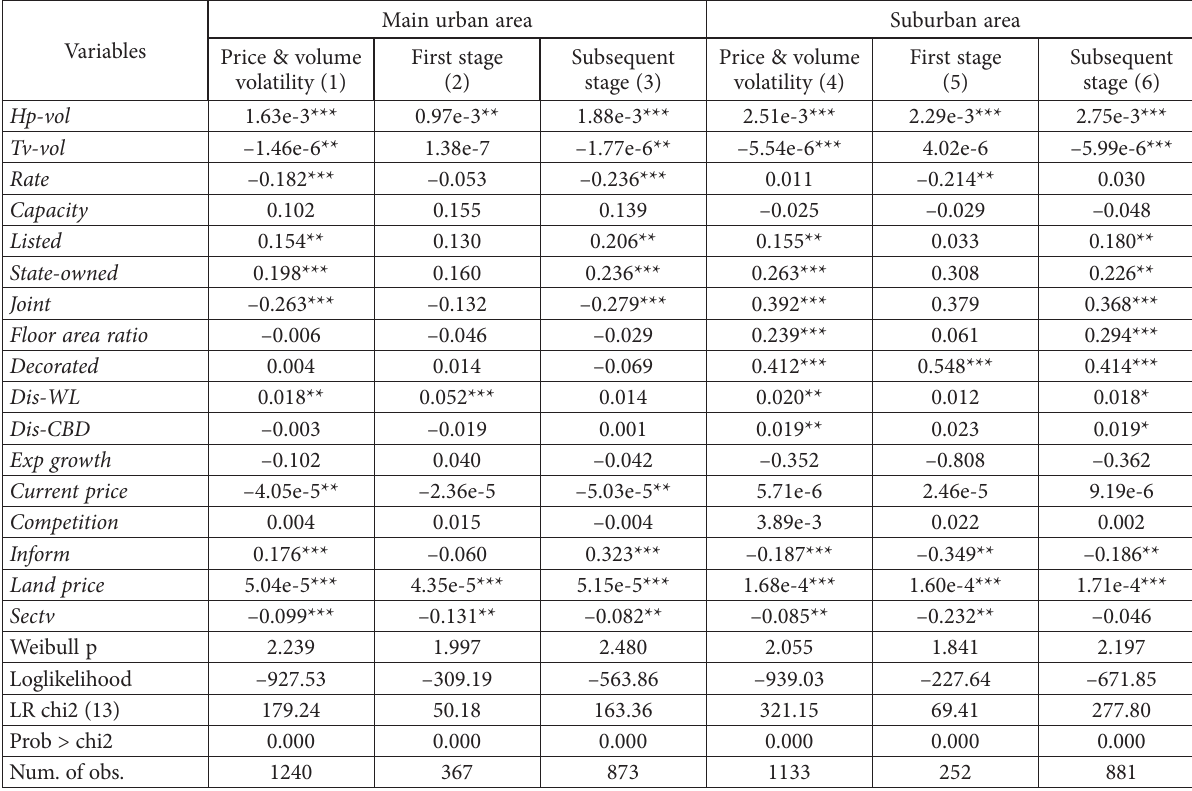
Table 4. Results of empirical research on the timing of sales in main urban and suburban